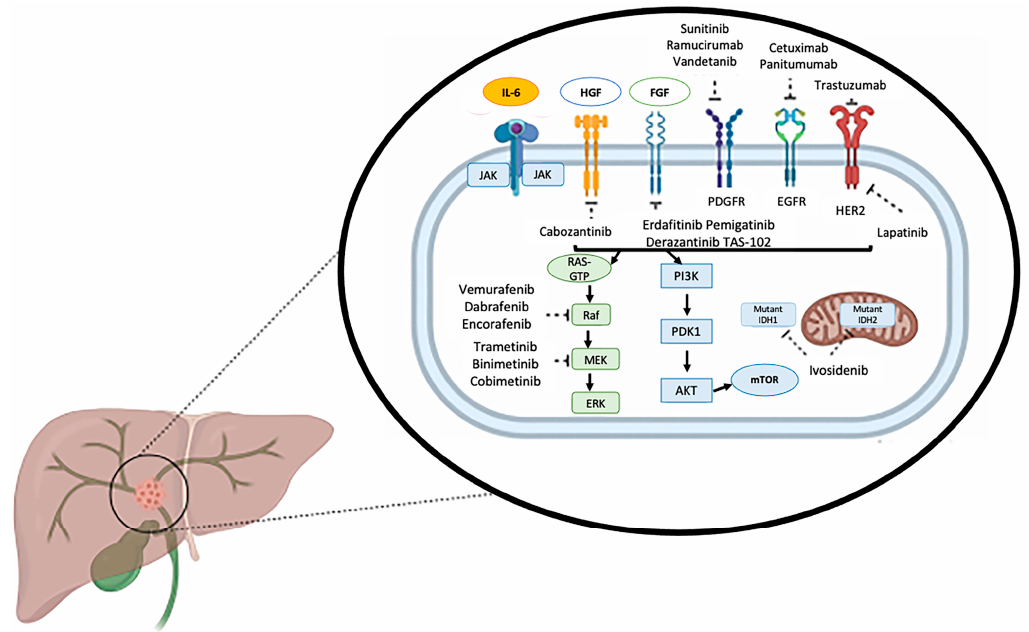
Figure 3. Schematic representation of therapeutically relevant signaling pathways and selected targeted therapies currently under evaluation in biliary tract cancer, reproduced from Rizzo et al. [47]. AKT: protein kinase B; EGFR: epidermal growth factor receptor; FGF: fibroblast growth factor; HER2: epidermal growth factor receptor 2; HGF: hepatocyte growth factor; IL-6: interleukin 6; IDH: isocitrate dehydrogenase; JAK: Janus kinase; mTOR: mammalian target of rapamycin; PDGFR: platelet derived growth factor receptor; PDK1: phosphoinositide-dependent kinase-1; PI3K: phosphoinositide 3-kinase.